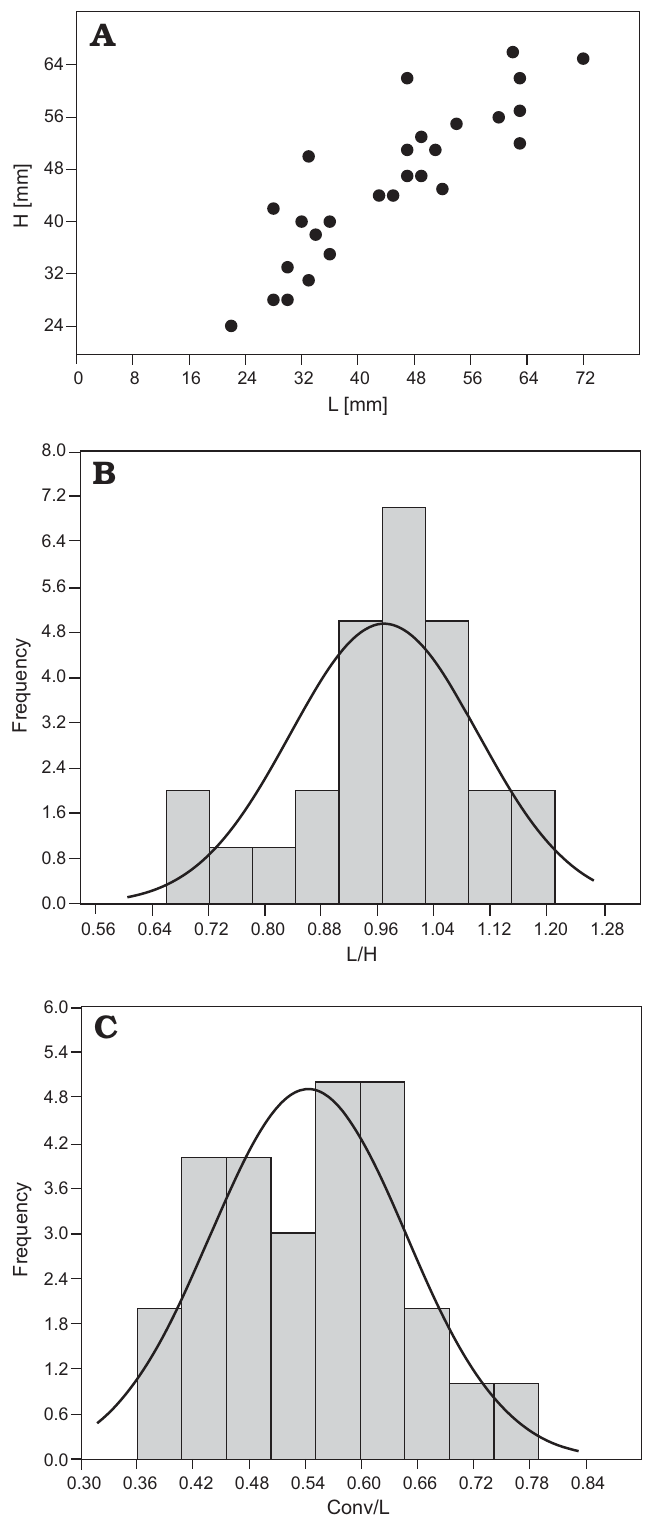
Fig. 5. Variability of pycnodontein oyster Pycnogryphaea weberae (Yanin in Tschelzova, 1969) from Berriasian of Crimea, section Balki village, Dalmasiceras tauricum Subzone. A . Length vs. height, N = 27. B . Length/ height frequency, N = 27. C . Convexity/length frequency, N = 27. Conv, convexity of shell; Conv/L, convexity coefficient; H, shell height; L, shell length; L/H, elongation